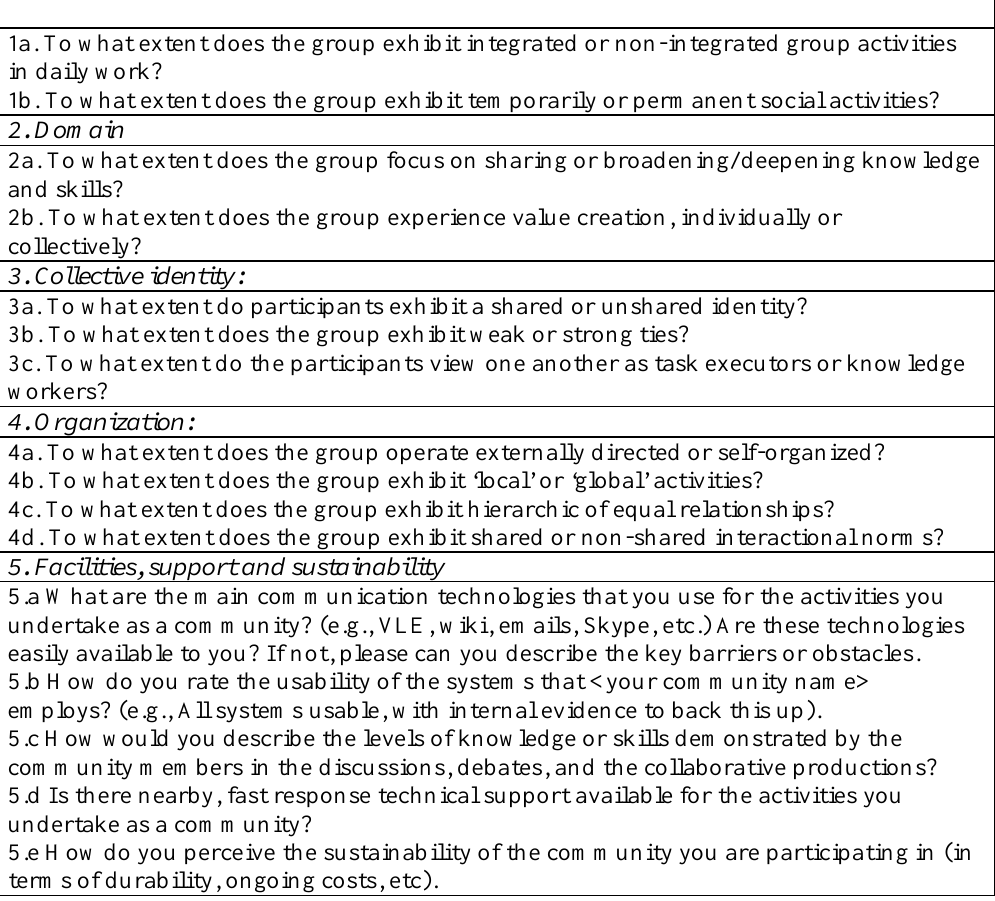
Dimensions and their Indicators of Social